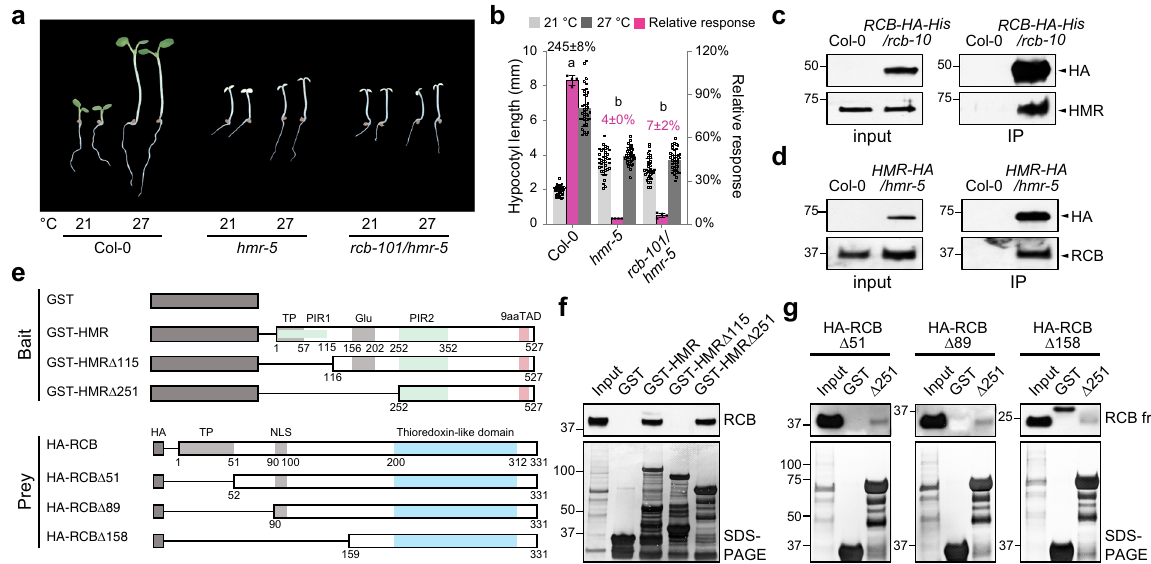
Fig. 6 RCB directly interacts with HMR. a Representative images of 4-d-old Col-0, hmr-5 , and rcb-101/hmr-5 seedlings grown in 50 μ mol m − 2 s − 1 R light in either 21 or 27 °C. b Hypocotyl length measurements of the seedlings shown in ( a ). The percent increase in hypocotyl length (mean ± s.d., n = 4 biological replicates) of Col-0 in 27 °C is shown in black above its columns. The magenta bars show the relative response. Error bars for the hypocotyl measurements represent s.d. ( n > 30 seedlings); error bars for the relative responses represent the s.d. of four biological replicates. The centers of the error bars represent the mean values. Purple numbers show the mean ± s.d. values of relative responses and different letters denote statistically signi fi cant differences in relative responses (ANOVA, Tukey ’ s HSD, p < 0.01, n = 4 biological replicates). c , d Reciprocal co-immunoprecipitation experiments showing the interaction between RCB and HMR in vivo. c Immunoblots showing the co-immunoprecipitation results using 4-d-old RCB-HA-His/rcb-10 seedlings grown in 10 μ mol m − 2 s − 1 R light. RCB-HA-His was pulled-down using Pierce ™ anti-HA agarose. RCB-HA-His and HMR from the input and pulldown fractions were detected by immunoblots using anti-HA and anti-HMR antibodies, respectively. d Immunoblots showing the co-immunoprecipitation results using